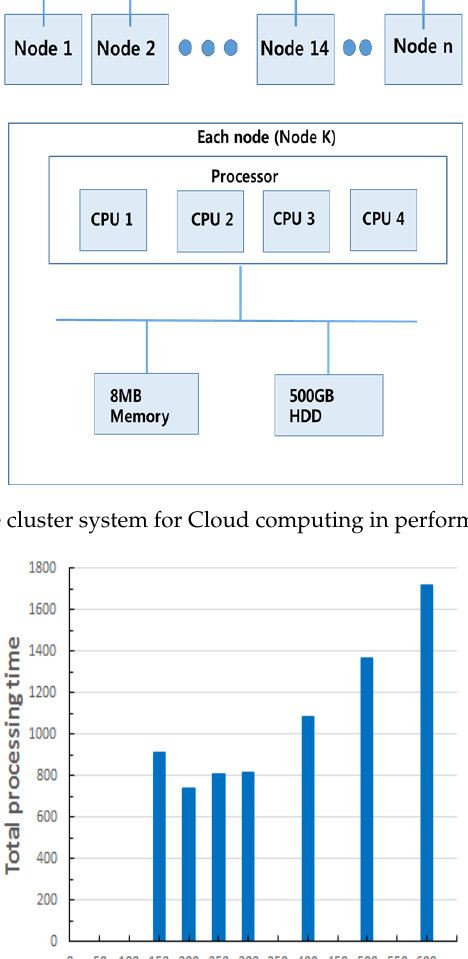
Figure 10. The total processing time when the number of frames allocated to each map task was increased.